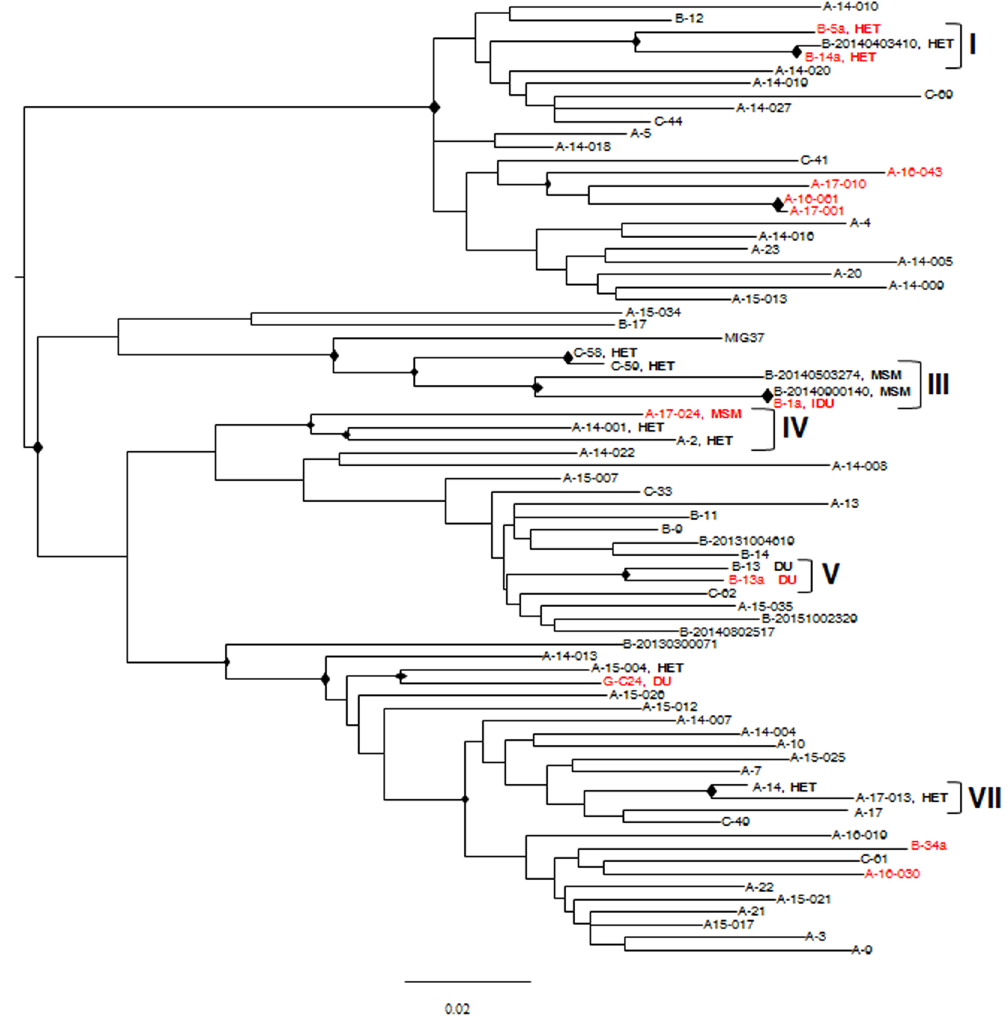
Figure 5. Clustering analysis of HIV-1 sequences from 12 Italians and 63 immigrants infected by HIV-1 non-B subtypes, according to HIV risk behaviour and demographical data. ML trees are shown. The diamond ( ♦ ) located in the nodes represents significant statistical support for the clade subtending that branch (bootstrap support > 70%). Roman numbers indicate clusters. Names in the cluster include the city one-letter code and an internal patient code. The risk factor (DU: Drug User; HET: Heterosexual; MSM: Male-to-Male Sex) is reported only for patients included in a cluster. Italian natives are indicated in red, immigrants in black. The scale bar indicates 0.02 nucleotide sequence